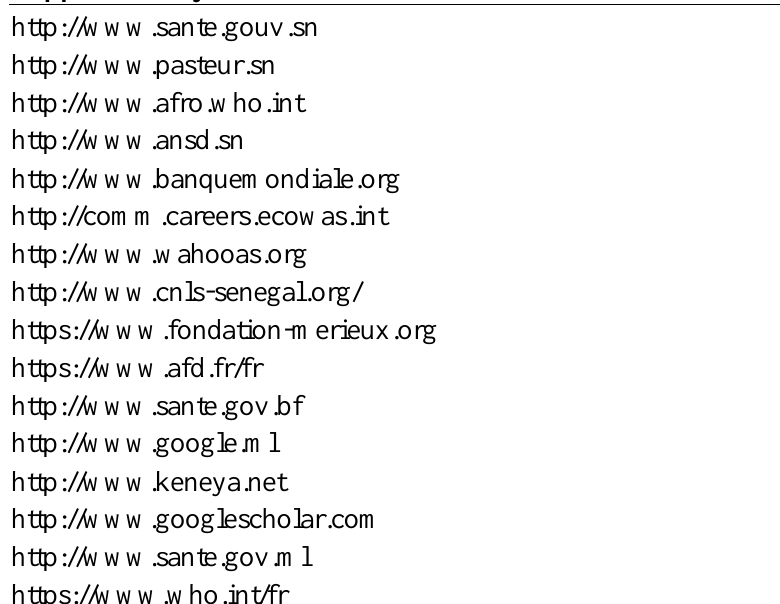
Supplementary LIST 1 : Websites visited for literature